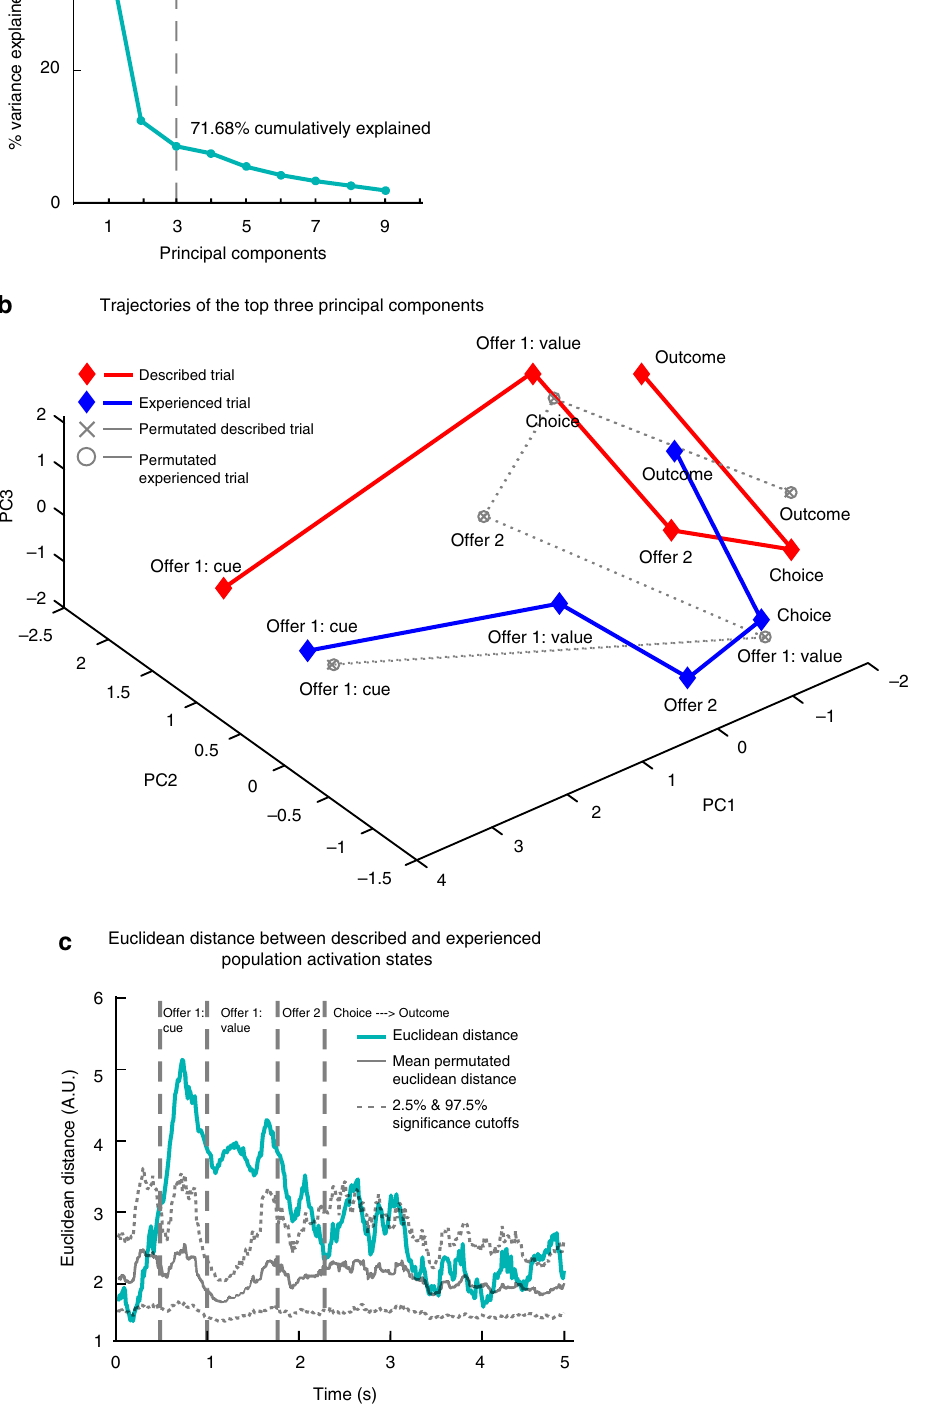
Figure 6 | Principal Component Trajectories. Population activation states from described and experienced trials converged as trial proceeded. ( a ) Scree plot: total variance in the data explained by number of principal components. Top three principal components together explained 71.68% of the variance in the data. ( b ) Trajectories based on the top three principal components: population activation states from the two trial types took up mirrored but separate coordinates in the top PC space, which gradually converged as trial proceeded. ( c ) Euclidean distance between population activation states from described and experienced trials: data are aligned at the beginning of cue epoch for offer 1 ( x -axis). Population activation states were most separated during prospective evaluation; this separation reduced to below significance when choice was carried out and reward was delivered. Dotted grey lines indicate significance cutoffs calculated from 1,000 iterations of permutation test and the solid grey line indicates mean Euclidean distance from permuted